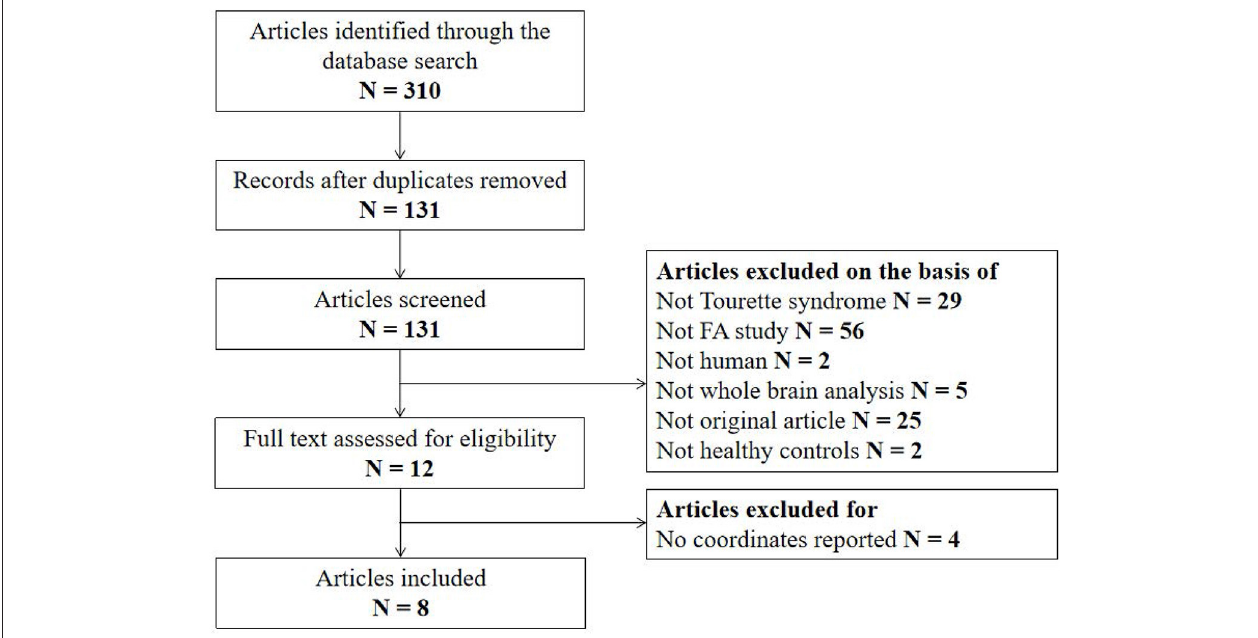
FIGURE 1 | Flow diagram for the identification and exclusion of studies. N, number; FA, fractional anisotropy.